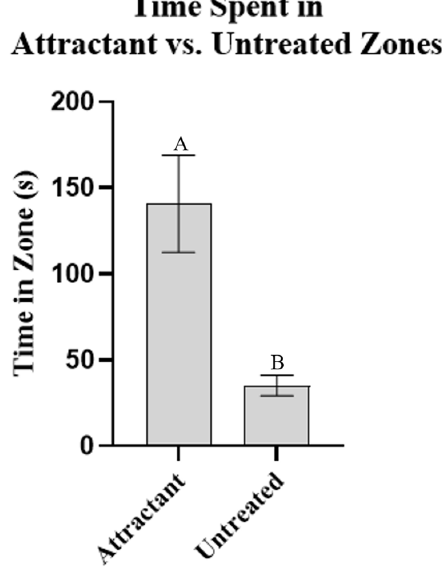
Figure 3. Repellent activity in presence of aggregation pheromone components, baseline results. Amount of time (mean +/ − SEM) the subject spent in zone treated with attractant [equal parts by volume of ( E )-2-hexenal and ( E )-2-octenal, diluted 1:10,000 (0.01%) in acetone] compared to average of time spent in the three untreated zones. Different letters above them are significantly different at α = 0.05. t -test: n = 20, p = 0.0007.